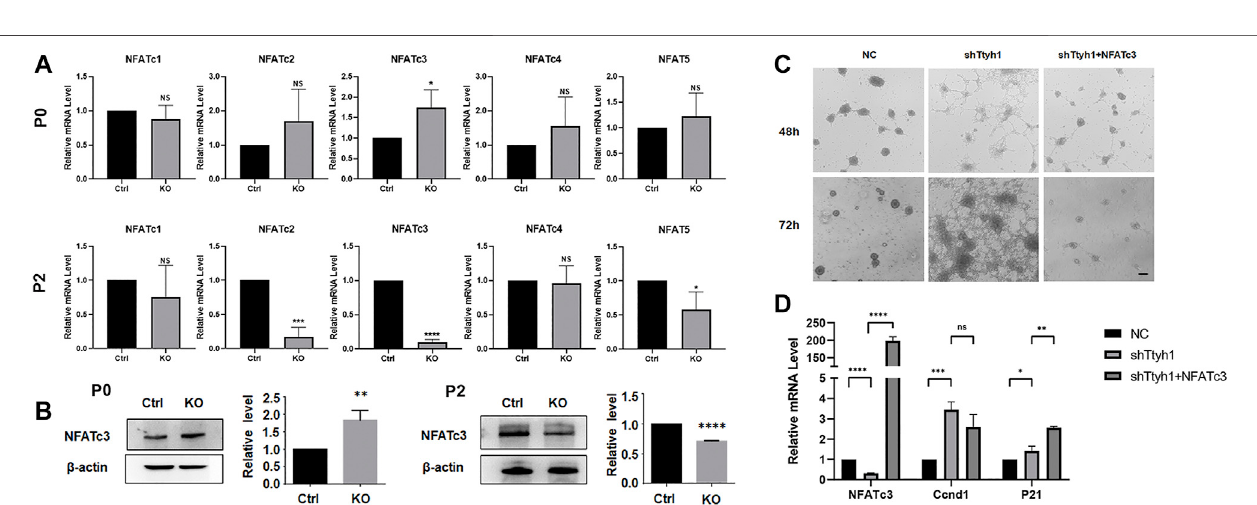
FIGURE 8 | NFATc3 is a key transcription factor in the regulation of cell cycle by Ttyh1. (A) RT-qPCR analysis showed the expression levels of fi ve NFAT family members between control and Ttyh1 KO neurospheres at primary culture (P0) and Passage 2 (P2). The RNA expression of NFATc3 increased at P0 and decreased signi fi cantly at P2. (B) Western blotting analysis showed the protein level of NFATc3 was also increased at P0 but decreased at P2. (C) Bright fi eld microscopy showed the morphological disparity among NSCs transfected with negative control shRNA (NC), shTtyh1, and shTtyh1+ NFATc3 (rescue group), respectively. After 48 or 72 hoftransfection,theresultsshowedthatoverexpressionofNFATc3partiallyrescuedthephenotypicchangescausedbyknockdownofTtyh1. (D) RT-qPCRanalysis showed that when Ttyh1 was knockdown, Ccnd1 was signi fi cantly increased, and p21 was slightly increased too. When NFATc3 was overexpressed at the same time, p21 increased signi fi cantly, whereas Ccnd1 showed a down-regulated trend. Scale bar (cid:2) 100 μ m in C. n ≥ 4 for all experiments. Data are expressed as mean ± SEM. Statistical signi fi cance was calculated using an unpaired, two-tailed Student ’ s t -test. ( pppp ) p < 0.0001, ( ppp ) p < 0.001, ( pp ) p < 0.01, ( p ) p < 0.05.